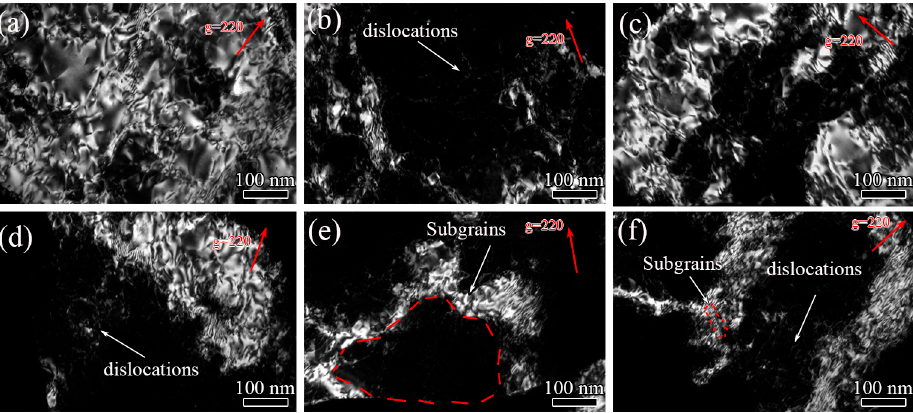
Figure 6. Dark-field transmission electron microscopy (DF-TEM) images of ( a – f ) pre-stretched an- nealed 7005 aluminum alloy plates (3%, 5%, 8%, 12%, 16%, and 20%, respectively).